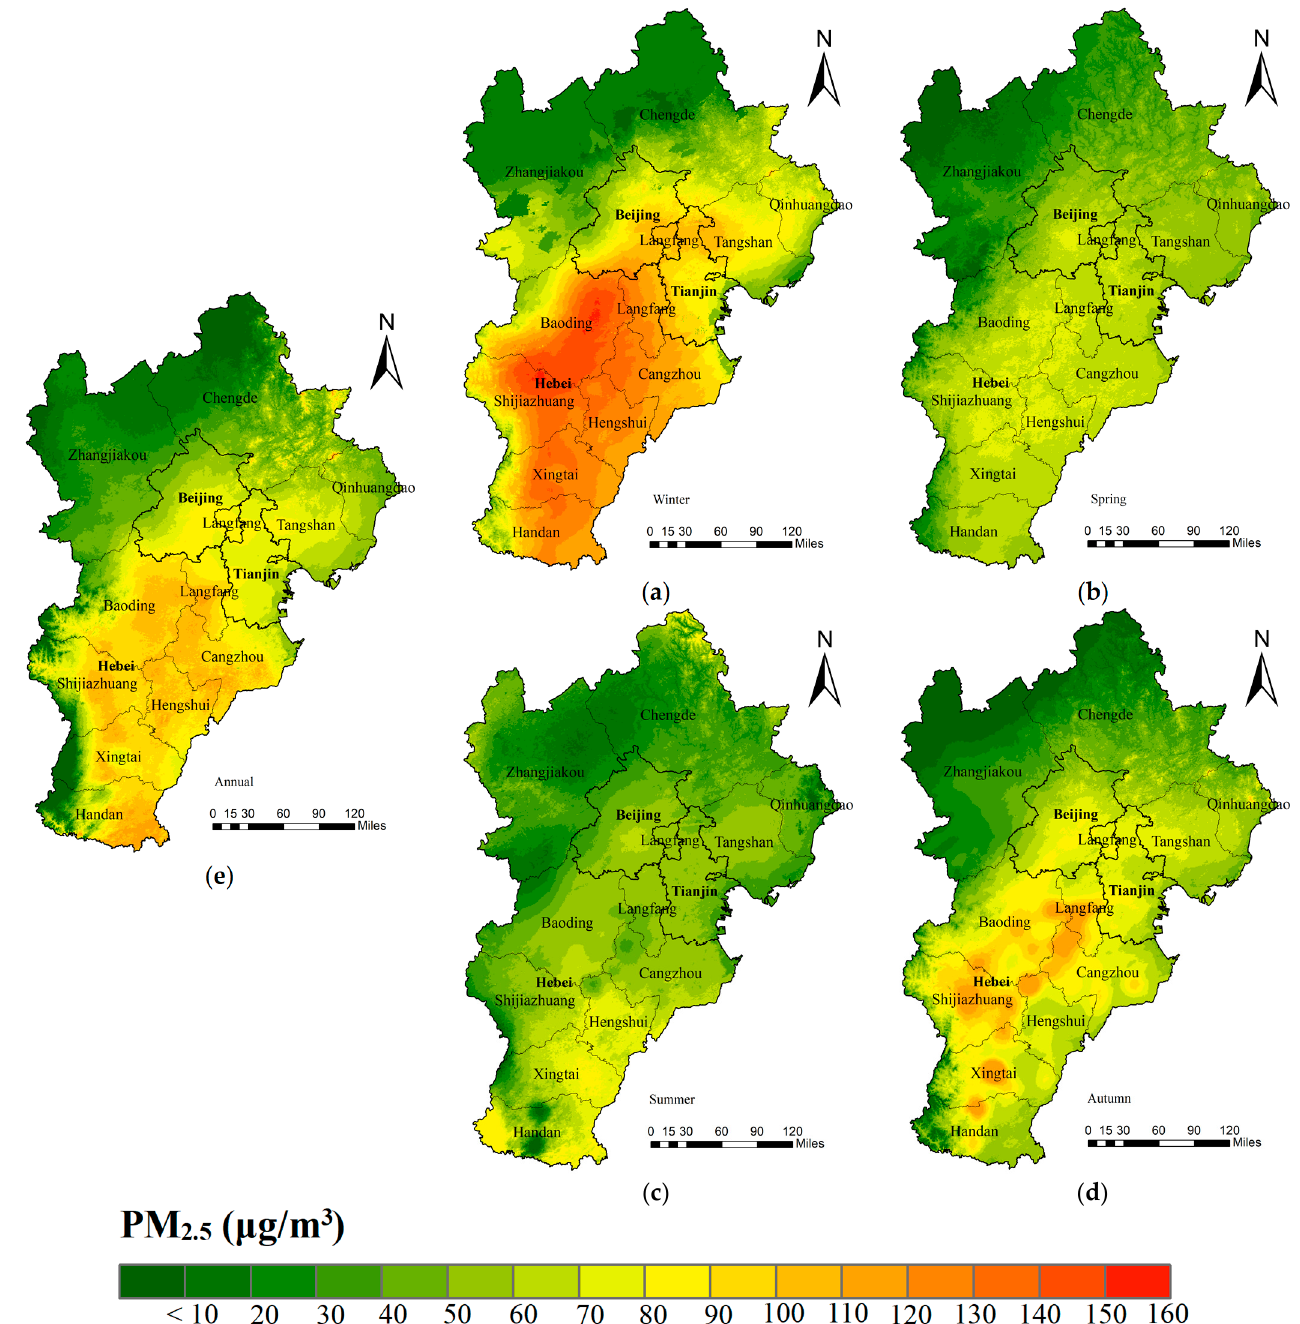
Figure 5. Estimated seasonal and annual PM 2.5 concentration distribution maps in the BTH region: ( a ) winter; ( b ) spring; ( c ) summer; ( d ) autumn; ( e ) annual. 3.3.2. Spatiotemporal Distribution Based on the PM 2.5 Distribution Maps As is shown in Table 6, the annual average PM 2.5 concentrations in the YRD and BTH regions were 44.85 and 80.21 µ g/m 3 , respectively, and the annual average PM 2.5 concentration in the BTH region was almost twice as high as that in the YRD region. The annual average PM 2.5 concentrations in the YRD region and the BTH region exceed the WHO interim target-1 (35 µ g/m 3 ) by 28% and 129%,